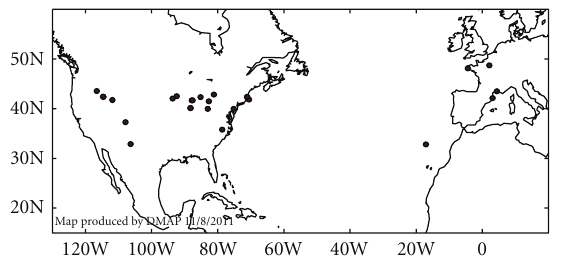
Figure 8: Distribution of Laboulbenia formicarum . North American records date from 1902 to 1979 and belong in 24 ant host species of five genera. European records date from 2003 to 2011 and imply two host species of Lasius